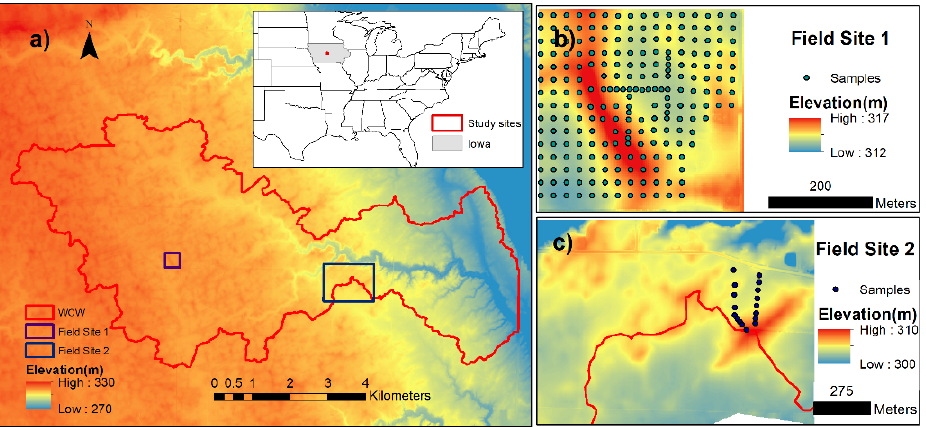
Figure 2. Locations of study fields: ( a ) Walnut Creek Watershed (WCW), ( b ) the intensive sampled field site 1, and ( c ) the transect field site 2. Table 2. Mean and standard deviation (SD) of soil organic carbon (SOC) density and soil redistribution rate (SR) at two field sites.